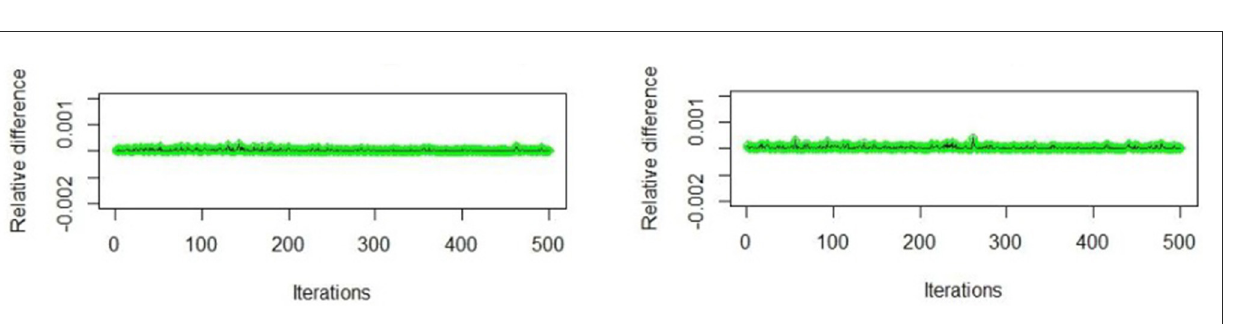
FIGURE3 Sample of visual monitoring of the difference (relative difference) between two successive evaluations of the log-likelihood, ε τ , ij ∼ ALD